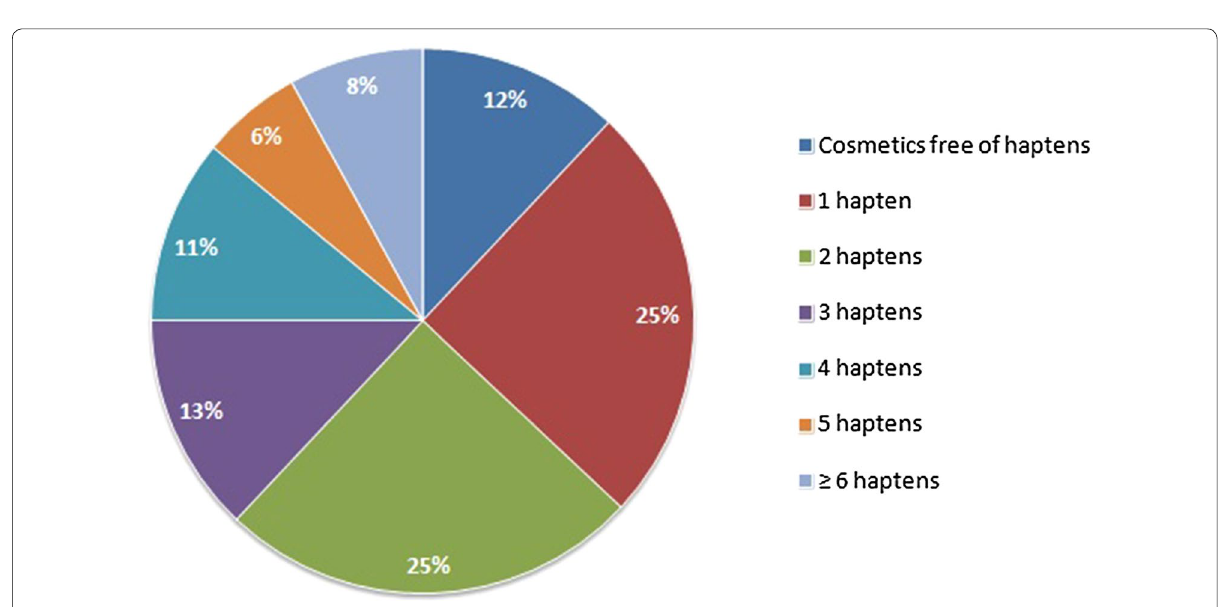
Fig. 1 Cosmetics containing different number of